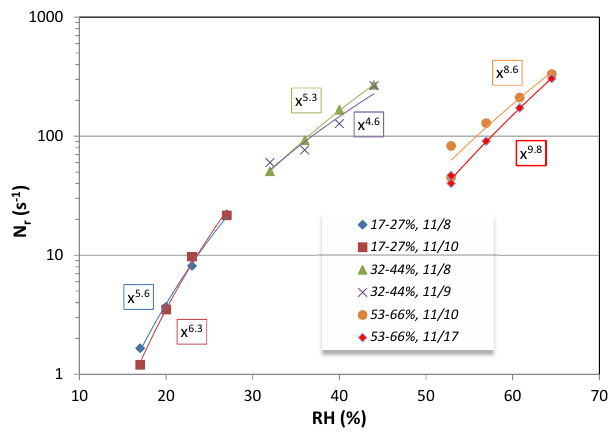
Fig. 4. Variation of N r with RH at constant [H 2 SO 4 ] (plus hydrates). Q A = 1sLpm for the low RH (17–27%) and medium RH (32– 44%) variations and 0.5sLpm for the high RH variation (53–66%). The power dependencies are shown in the figure.